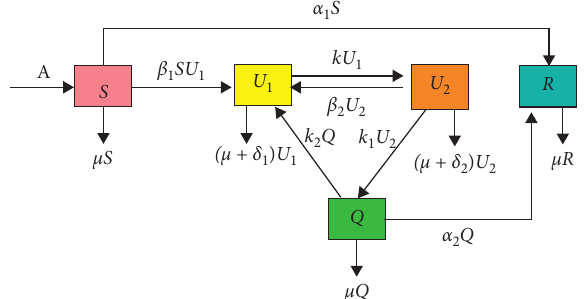
Figure 1: Transfer diagram of the heroin epidemic model with relapse and permanent